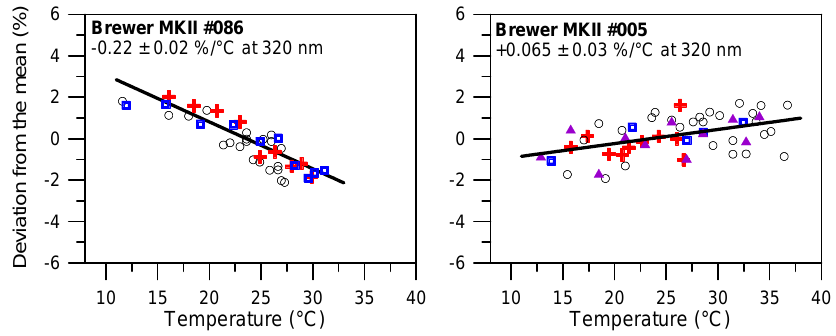
Fig. 5. Percentage deviation of lamp irradiance measurements at 320 nm from their mean, as a function of temperature. Measurements were performed in the laboratory using a 1000W DXW lamp. The slopes of the regressions represent the temperature coefficients for each instrument, in %/ ◦ C.